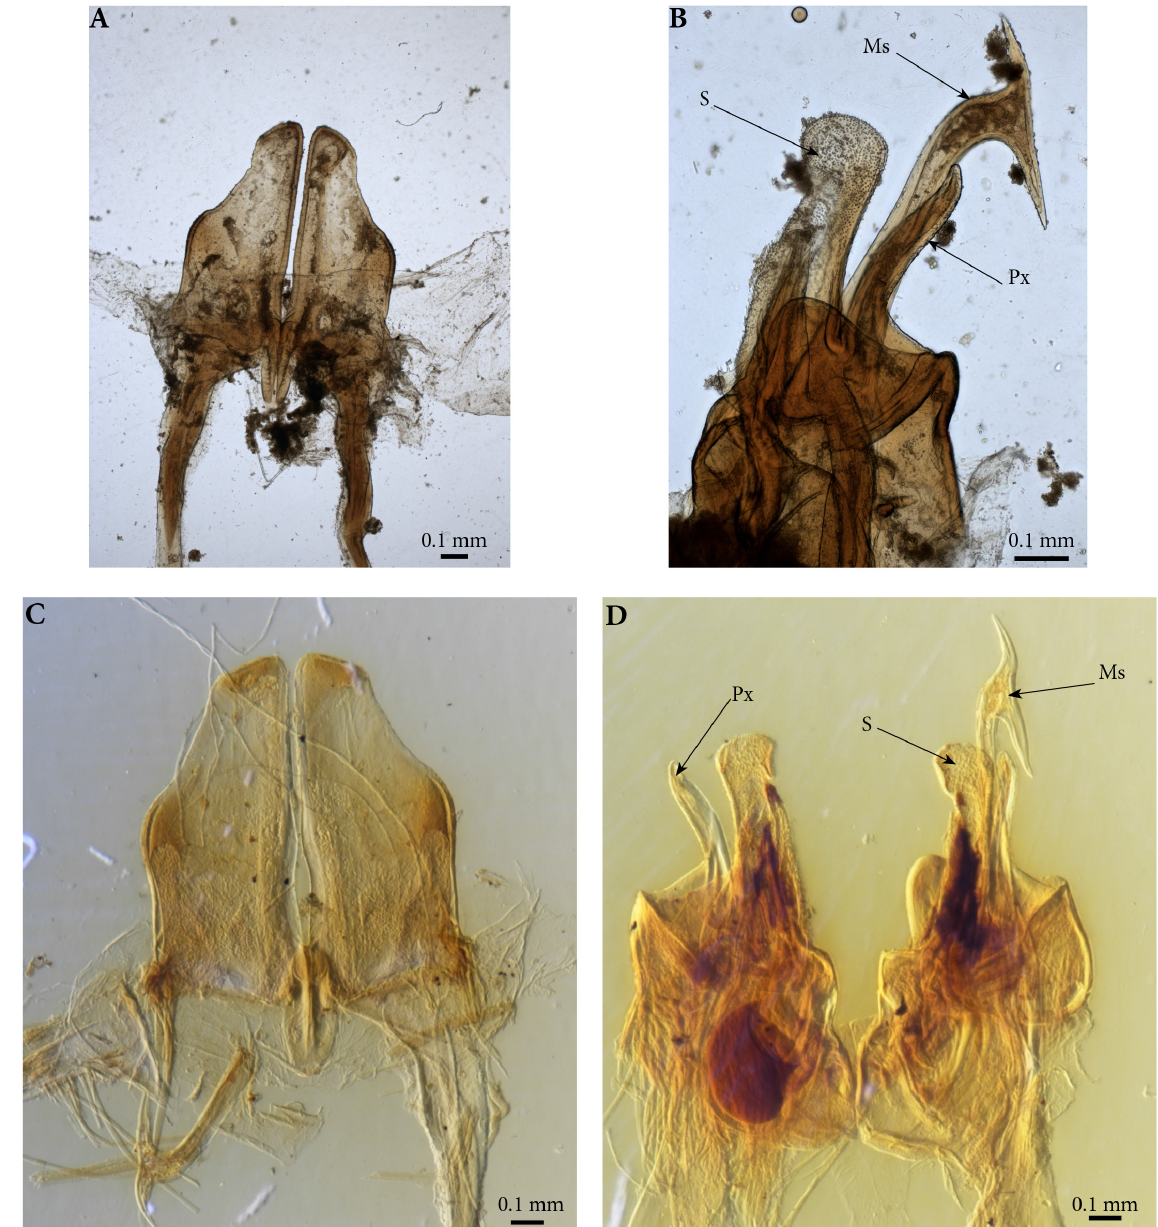
Fig. 17. Ommatoiulus oliveirae (Verhoeff, 1893). A–B . Syntype, slide preparation (ZMB 13086). A . Promerites, posterior view. B . Posterior gonopod, posterior view. C–D . Slide preparation (NHMW 8044). C . Promerites, posterior view. D . Posterior gonopods, posterior